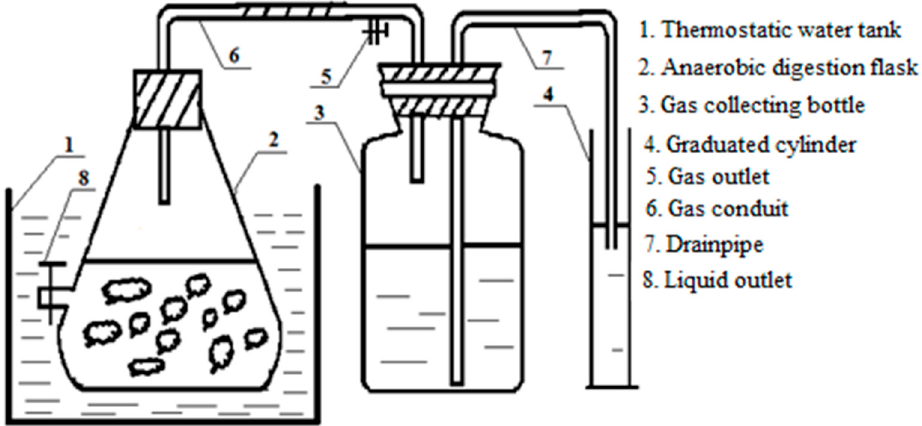
Figure 1. Sketch map of the anaerobic digestion (AD) equipment.